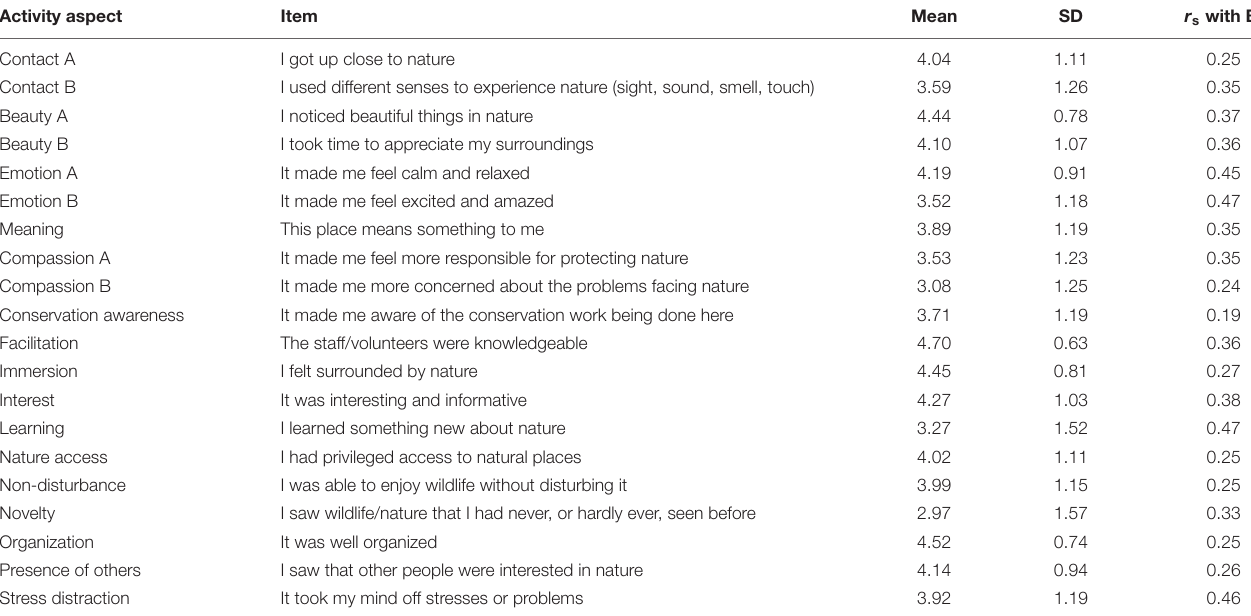
TABLE 1 | Activity aspects item descriptives and correlation with behavioral intention (BI; N =